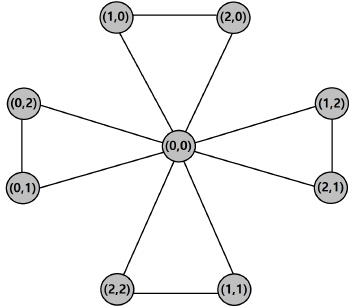
Figure 1: The linear dependence graph of the 2 -dimensional vector space W over the finite field F 3 = { 0 , 1 , 2 } where W = { (0 , 0) , (0 , 1) , (1 , 0) , (2 , 0) , (0 , 2) , (1 , 1) , (2 , 2) , (1 , 2) , (2 , 1) }